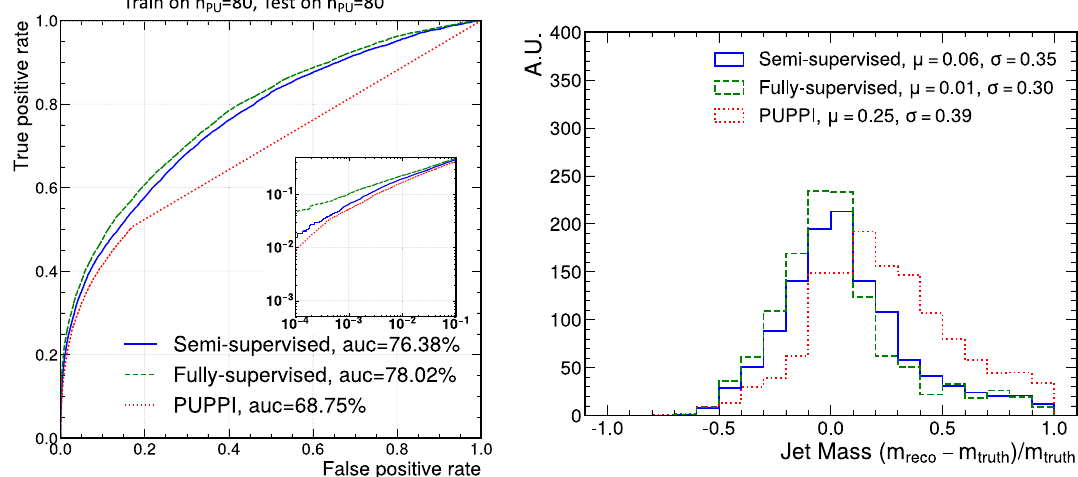
Fig. 11 The ROC curve for the gated GNN on neutral particles under n PU = 80 for SSL, fully-supervised learning, and the domain PUPPI algorithm for simulations with resolution